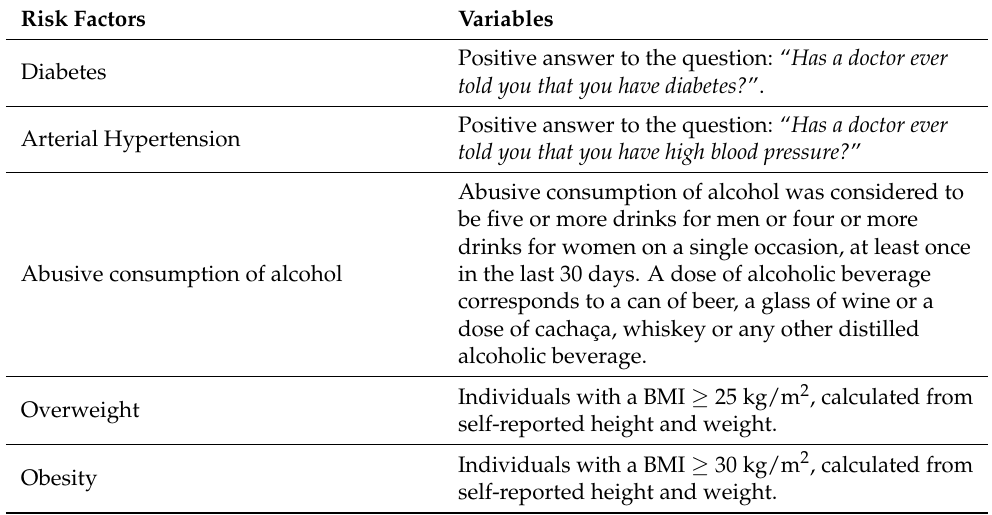
Table 1. Description of the variables of the questionnaire proposed by VIGITEL to define Diabetes, Arterial Hypertension, Abusive consumption of alcohol, Overweight and